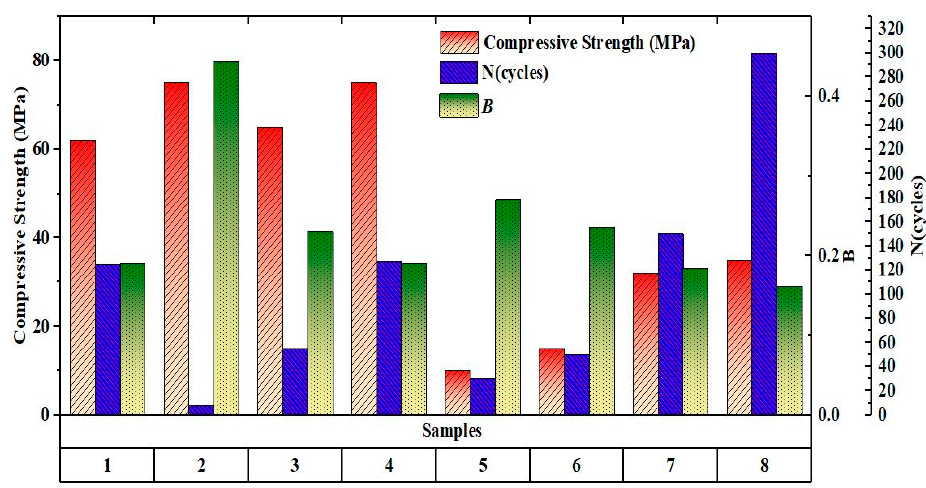
Figure 9. Value of β , compressive strength and number of cycles for different types of GPC.